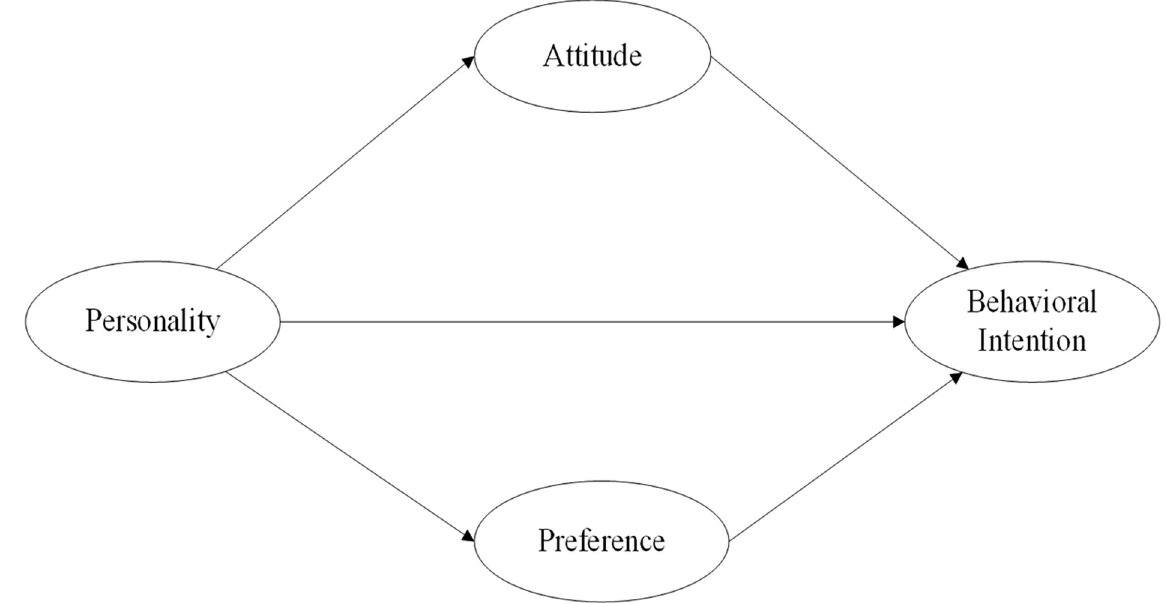
Fig 1. Modelling framework (personality-attitude & preference-intention